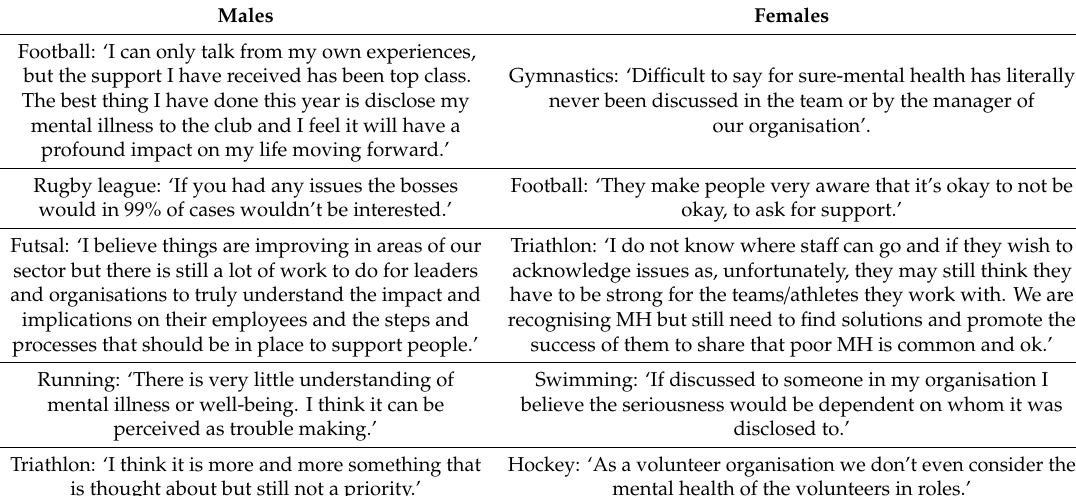
Table 6. Coaches’ perceptions of the seriousness with which mental health and illness are taken by their leader(s) and